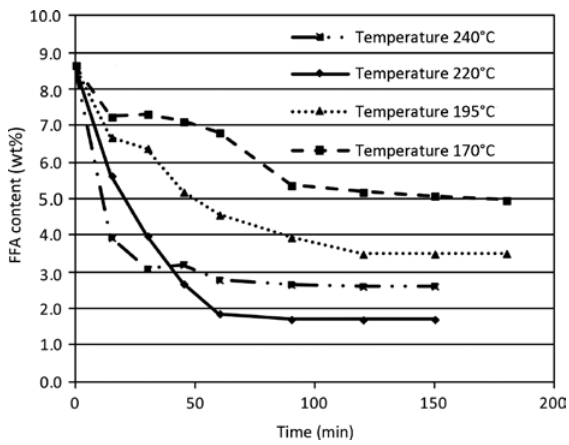
Figure 4: Influence of oil:glycerol mass ratio on free fatty acid (FFA) reduction (T = 220 ° C, p = 3